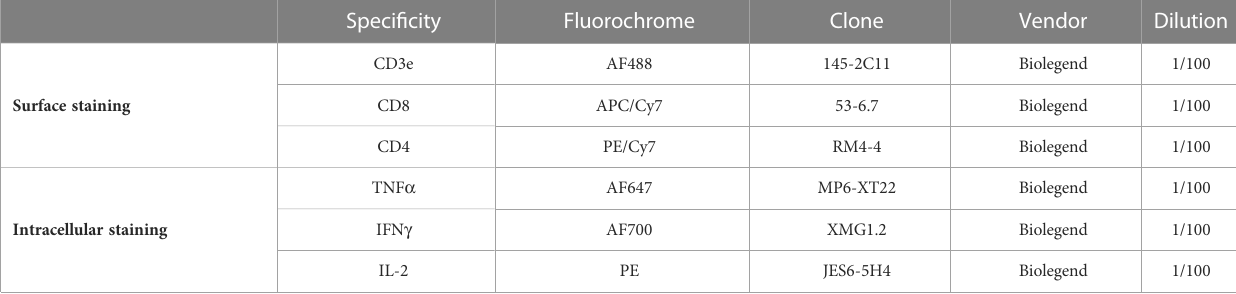
TABLE 2 Flow cytometry antibodies used in the polyfunctional T cell